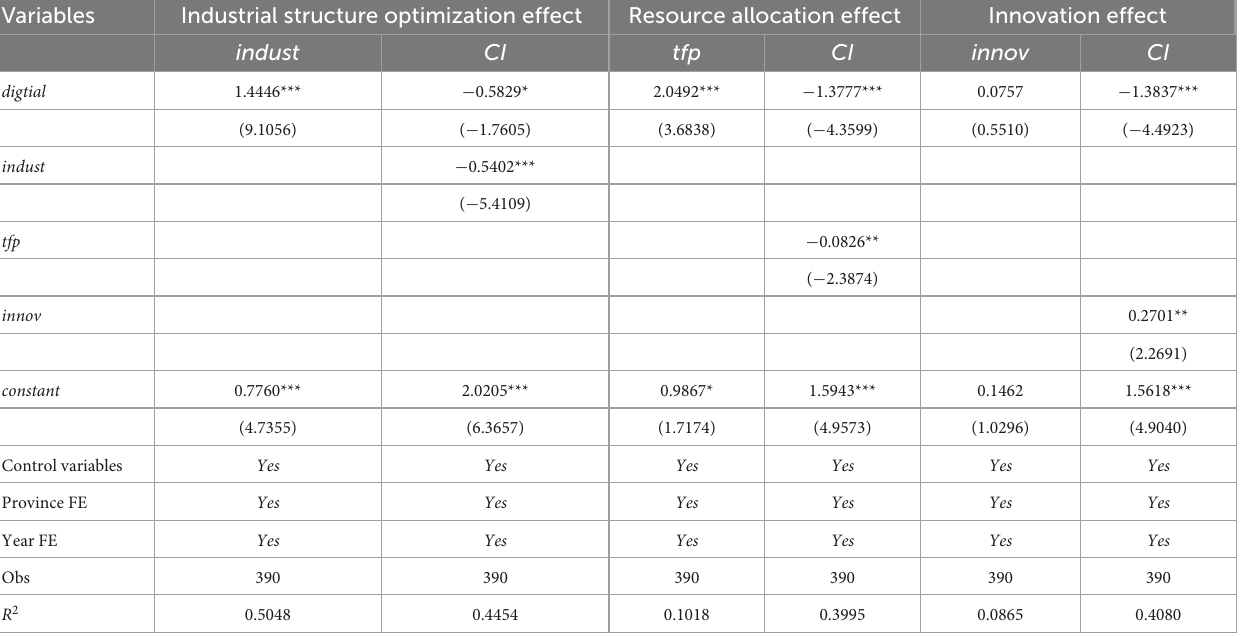
TABLE 9 Mechanism test